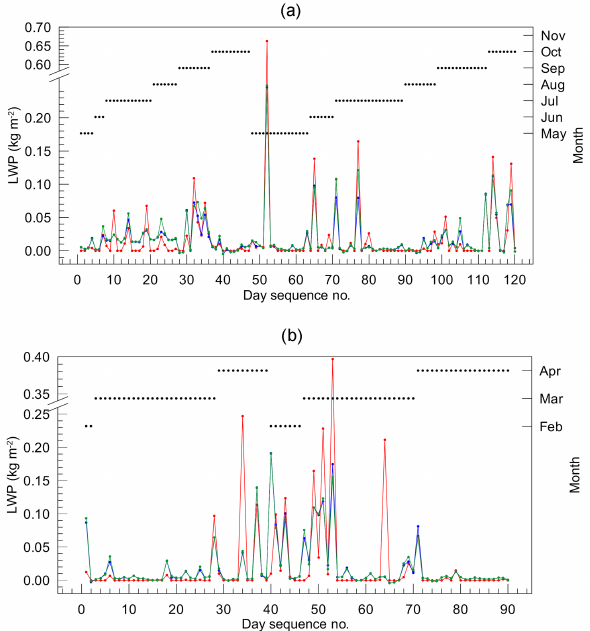
Figure 5. The daily median LWP values obtained by SEVIRI (red dots) and HATPRO (blue dots for HAT 10 − 20 and green dots for HAT 10 − 60 ) as a function of day sequence number for the WH and CD seasons ( a and b correspondingly). Colour dots are connected by lines only for demonstrative purpose. Black dots in combination with the right y axis indicate the month of measurements.